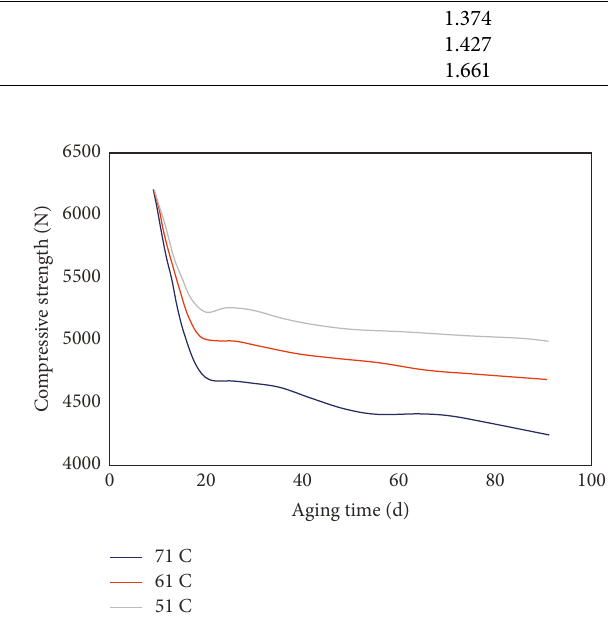
Figure 6: Change curves of compressive strength with aging time.